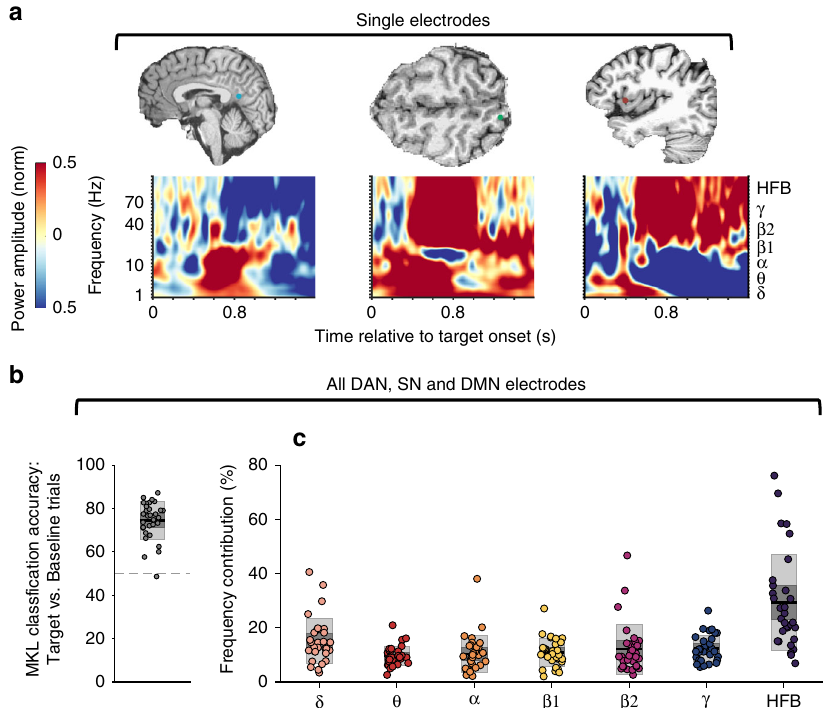
Fig. 2 Frequency-speci fi c contributions to task-evoked responses. a Example time-frequency plots highlighting spectral changes during correct omissions (mean across trials) for depth electrodes located within key nodes of the DAN (dorsal posterior parietal cortex), SN (dorsal anterior insular cortex), and DMN (posteromedial cortex). b Classi fi cation accuracy (correct omissions versus correct commissions) in 31 subjects based on multiple kernel learning analysis (full model with seven frequency ranges and all electrodes within the DAN, SN, and DMN). c Contributions of the power amplitudes of distinct frequency bands to the classi fi cation accuracy shown in b . In box plots, center lines indicate mean, dark gray areas indicate 95% con fi dence interval, and light gray areas indicate